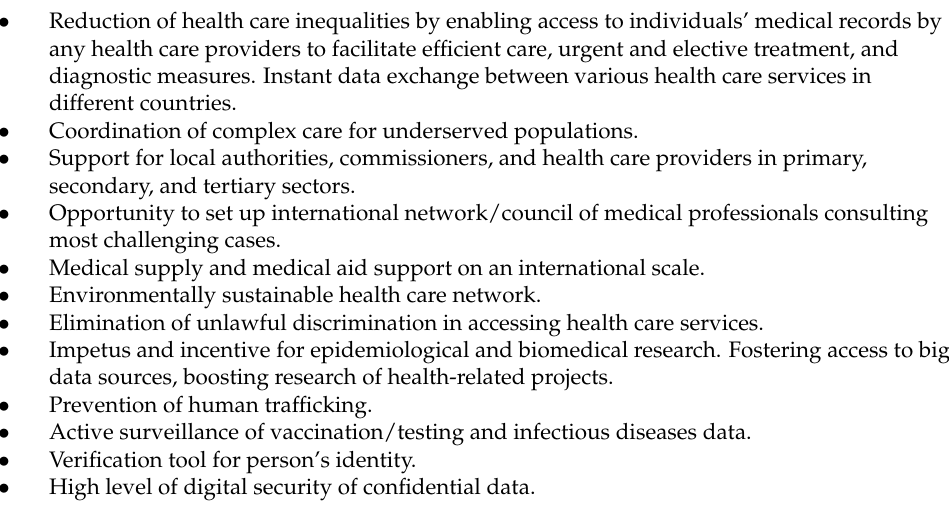
Table 1. Expected benefits of a central health-related data register governed by the European Union Council and associated